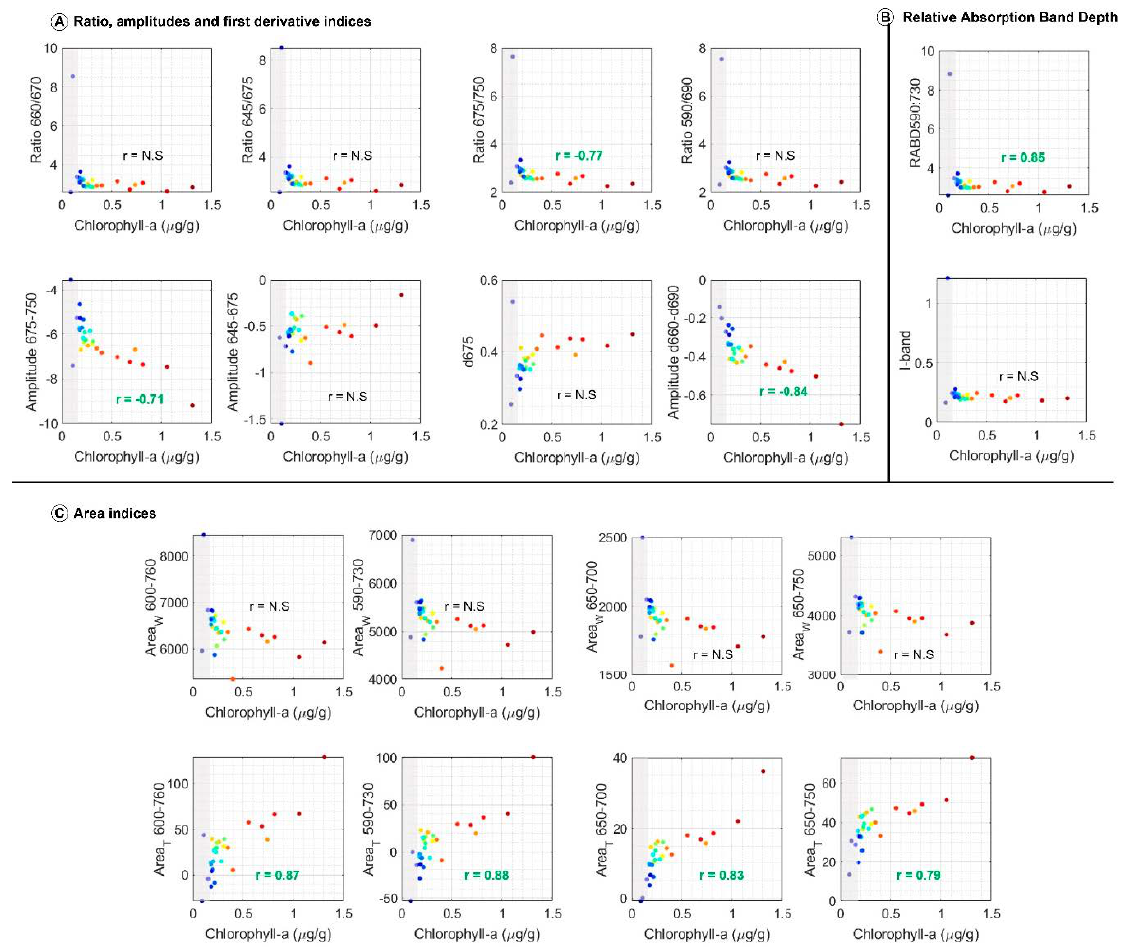
Figure 3. Scatter plots of 18 chlorophyll -a indices for the oxidized sedimentary matrix (following the routine protocol used in Balsam et al. [51]) and presented according to their typology, ( A ): ratio, amplitude and derivative indices, ( B ), RABD index and I-band (i.e., RABD/Rmean). The division of RABD by Rmean degrades the correlation. ( C ) Area indices. N.S. = Not Significant, p -value > 0.0001 (n = 28). The red dots indicate the top of the core and the blue color is for the bottom.